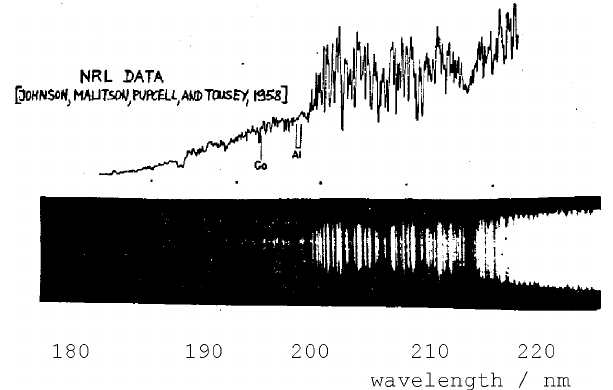
Figure 4. Photographic recording of solar chromospheric EUV spectra (Detwiler et al., 1961; copyright permission granted by the Société Royale des Sciences de Liège).